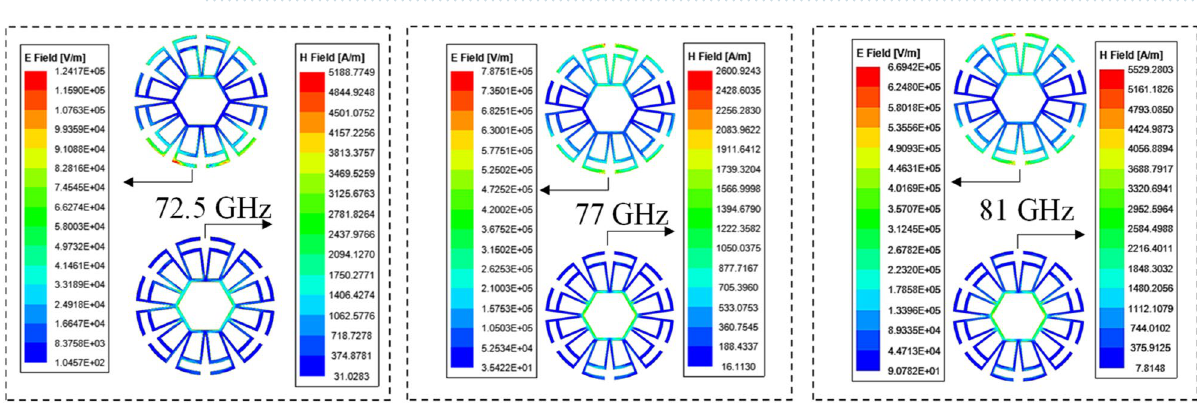
Figure 5. Brief design evolution of the proposed flower metamaterial-based antenna, and comparison of three of the figures of merit versus frequency.